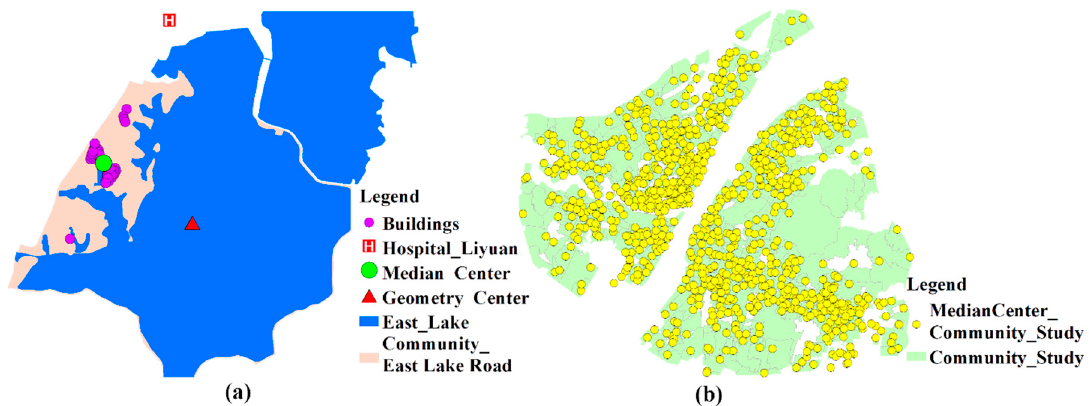
Figure 5. ( a ) The geometry center and median center of East Lake Road Community; ( b ) median centers of the study communities.